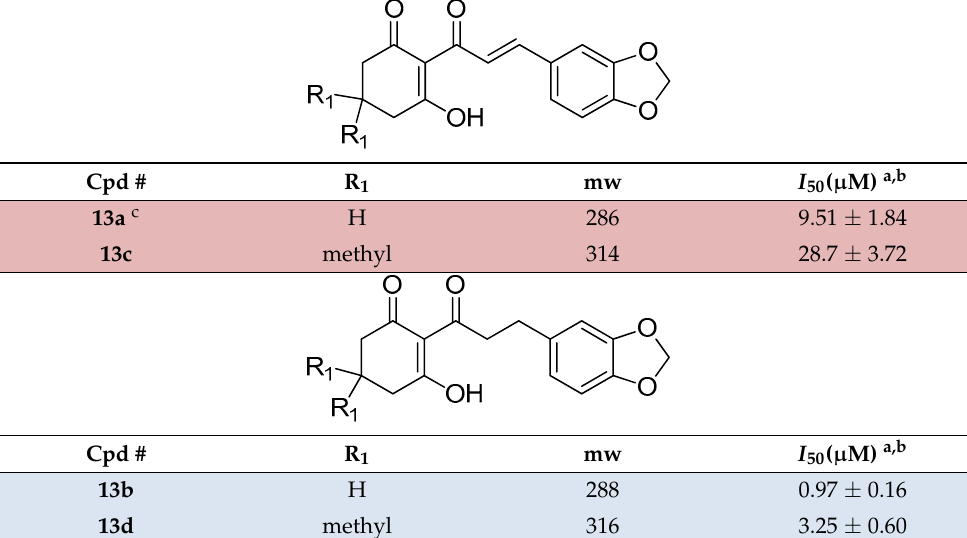
Table 4. Structures and activities of 4 cyclohexane-1,3-diones with other side chains tested in this study.